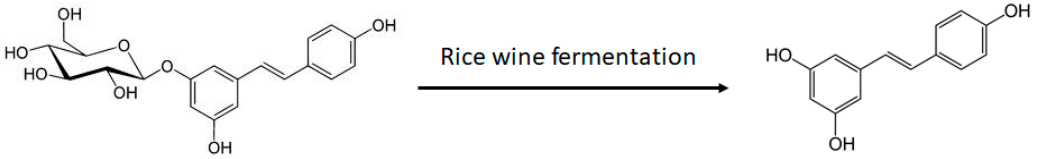
Figure 1. Scheme representing transformation of piceid to resveratrol during rice wine fermentation.